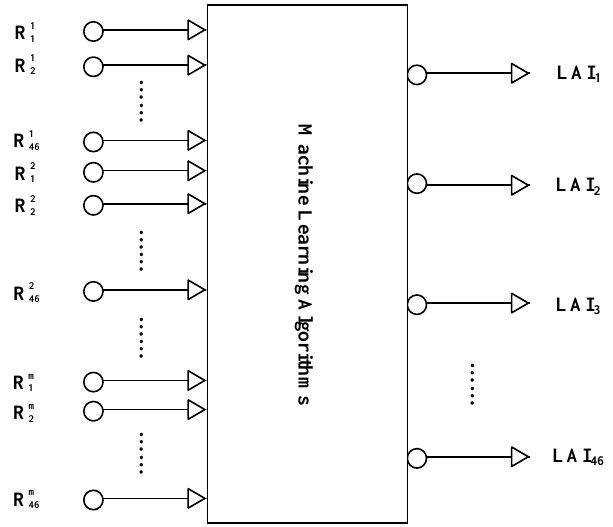
Figure 1. Schematic description of the method to retrieve leaf area index (LAI) values from time-series Moderate Resolution Imaging Spectroradiometer (MODIS) surface reflectance data.